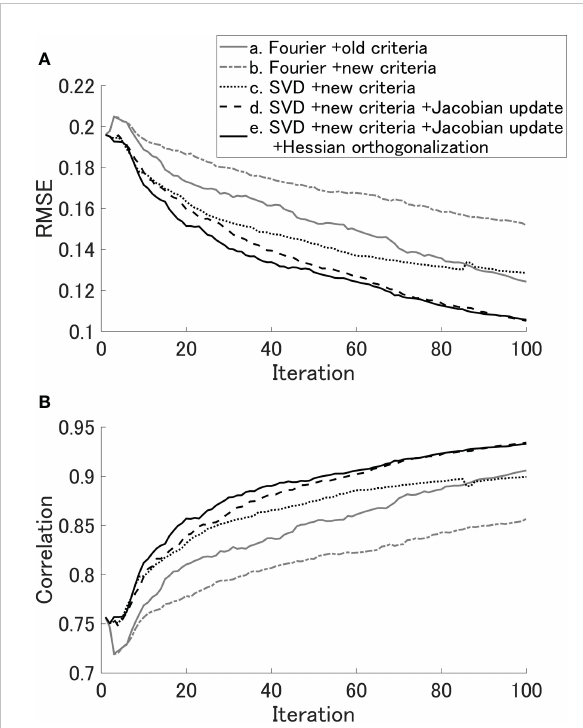
FIGURE 5 Estimation error within the LPZP averaged over the 10 realizations of the white Gaussian noise.